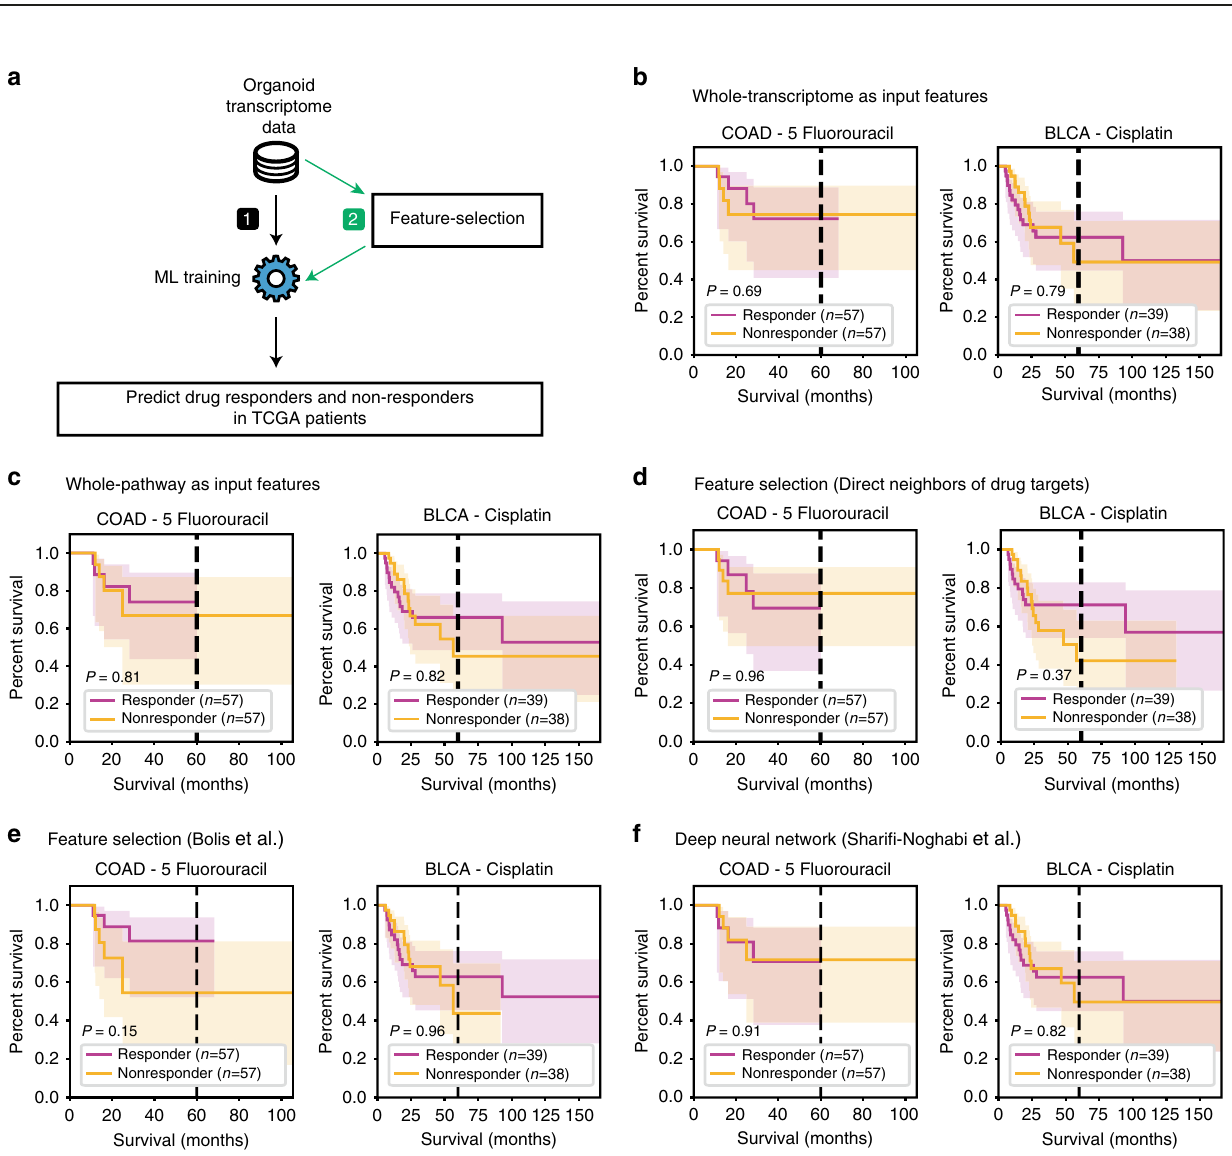
Fig. 3 Drug-response predictions using other machine-learning methods. a Overall scheme of other drug-response prediction methods using (1) no feature selection and (2) a feature selection process. b – d Survival predictions were trained using ( b ) whole-genome pro fi les, ( c ) whole-pathway pro fi les, ( d ) fi rst neighbors of drug targets, ( e ) feature selection (Bolis et al.), and ( f ) a deep-learning method (Shari fi -Noghabi et al.). Kaplan – Meier survival plots and two-sided log-rank test P -values are displayed. COAD, colorectal cancer; BLCA, bladder cancer. predictive performances of feature selection based on (1) network used three different measurements (degree, betweenness, and centrality, (2) direct network neighbors of drug targets, and (3) closeness centrality) to calculate the centrality of each pathway the pre-selection of genes with expression levels highly correlated (see “ Methods ” for details). Feature selection was conducted by to drug responses (see “ Methods ” ). We found that all of the tested selection of network central pathways that matched the number feature selection methods were not strong predictors of patient of proximal pathways. We found that all of the combinations of survival (Fig. 3d, e, Supplementary Figs. 6 and 7). More different feature selection procedures based on network centrality speci fi cally, for feature selection based on network centrality, we were not strongly predictive of patient survival after drug NATURE COMMUNICATIONS| (2020) 11:5485